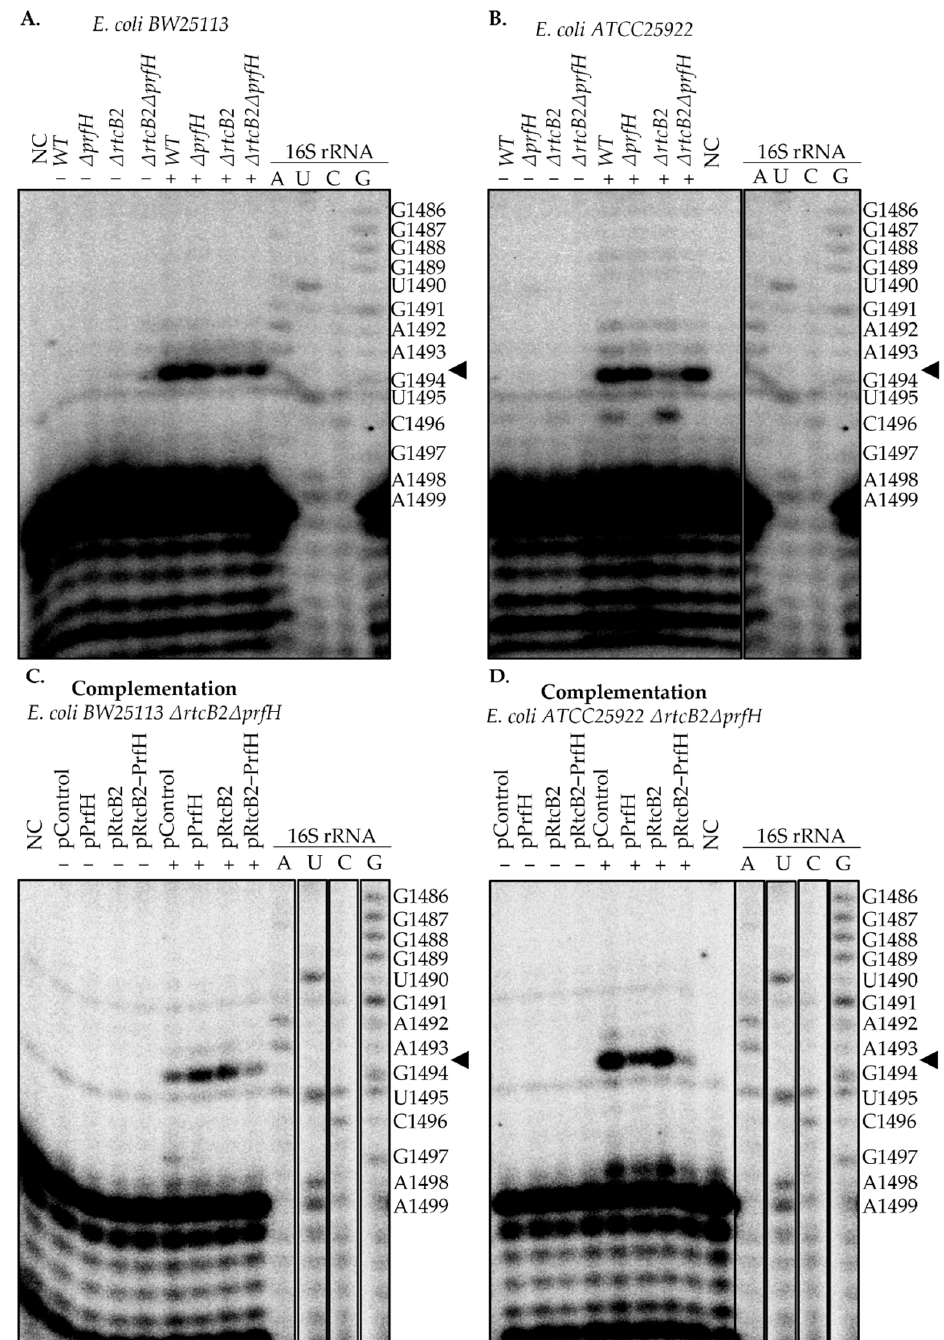
Figure 3. Primer extension results showing the cleavage analysis of 16S rRNA under in vivo colicin E3 treatment for wild-type and knockout strains shown for ( A , B ), including complementation ( C , D ) of the double knockouts with single and both gene expression from the rtcB2 - prfH operon. Untreated and treated bacterial cells with colicin E3 were used to isolate total RNA. About ~500 ng of template RNA was used for annealing with a γ -[ 32 P] ATP labeled reverse primer complementary to the 16S rRNA. The resultant cDNA products synthesized by AMV reverse transcriptase were then separated by a 20% denaturing polyacrylamide gel electrophoresis. The sequence reactions were used to map the cleavage sites obtained. The results were consistent and reproducible at least twice when the experiment was repeated under treatment with colicin E3. NC is a negative control, wherein Milli-Q ultrapure water was used instead of total RNA purified from the samples.